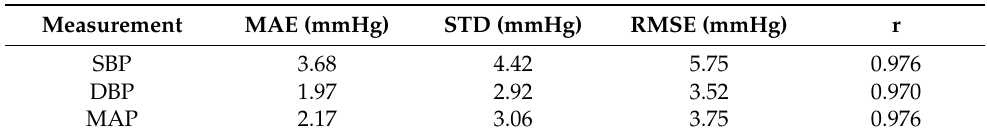
arterial pressure (MAP) values prediction.